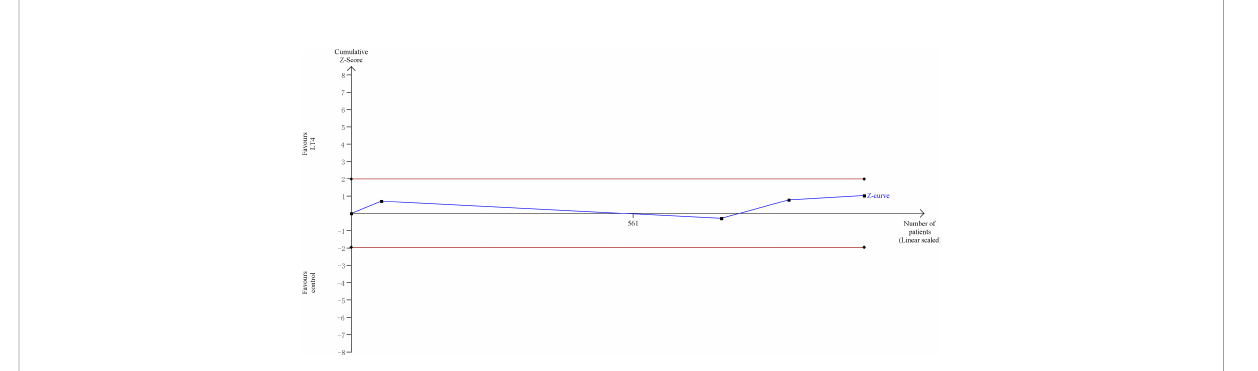
FIGURE 6 Trial sequential analysis of gestational diabetes. The risk of type I error was set at 5% with a power of 80%. The variance was calculated from the data obtained from the included trials. The relative risk reduction (RRR) was set at